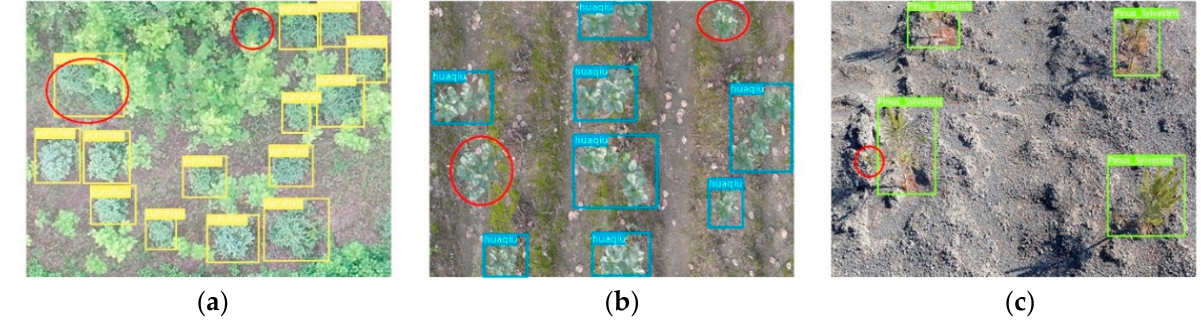
Figure 10. Examples of the missed detection of tree seedlings for ( a ) dragon spruce, ( b ) black chokeberries, and ( c ) Scots pine.